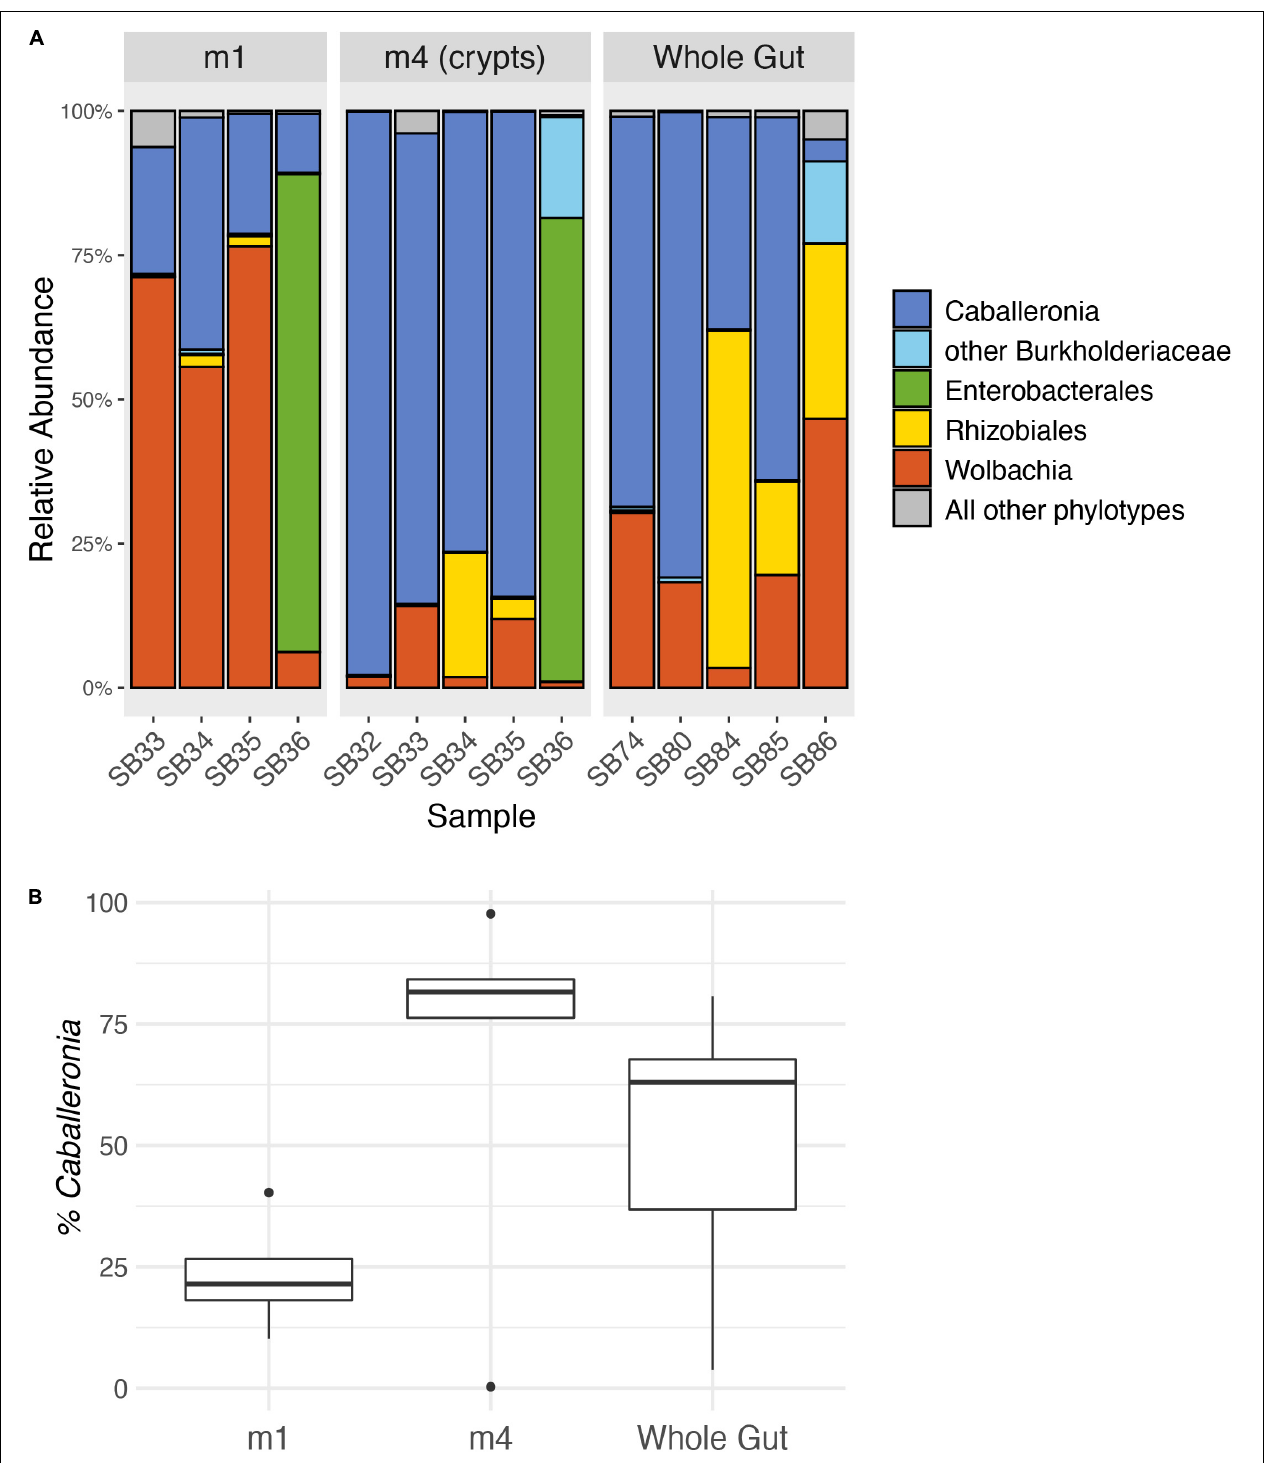
FIGURE 3 | Relative abundance of 16S rRNA gene MiSeq reads from adult squash bug midgut sections. (A) MiSeq reads are grouped into genus-level phylotypes and labeled with the lowest certain taxonomic classification according to RDP classification. The five most abundant phylotypes are shown, and all other phylotypes are combined. The M1 and M4 samples were taken from the same individuals. The M1 for individual SB32 is not included because it failed to amplify. (B) Percentage of reads classified as Caballeronia in each midgut sample. Boxplots indicate the interquartile range with a box, the median as a bold line within the box, and outliers as points. The whiskers indicate the minimum and maximum values up to 1.5 × the interquartile range. Values beyond this range are indicated as outliers.